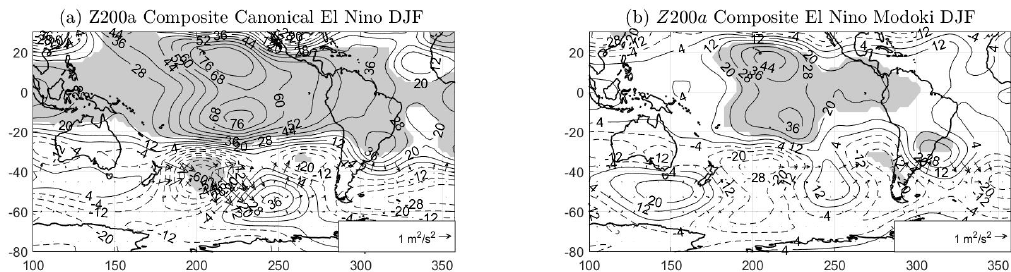
Figure 3. Composite z200 anomaly map for ( a ) Canonical El Niño and ( b ) El Niño Modoki. Vectors represent the F s field. Shaded regions exceeded the 95% level of confidence from a two-tailed t -test. z200a units: m, v850 units: m / s and F s units: m 2 s 2 . Results from reanalysis data.